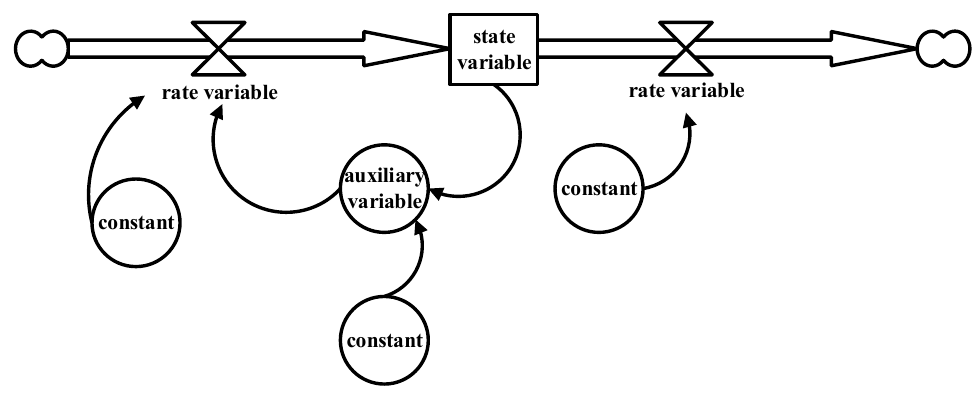
Figure 1. The b asic structure of SD. Figure 1. The basic structure of SD.